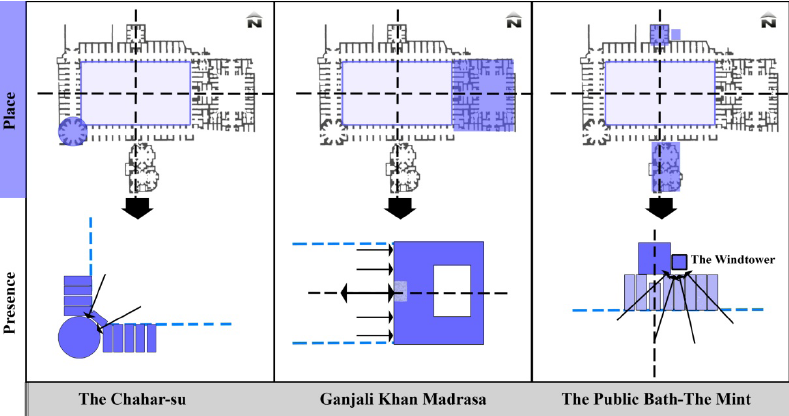
Figure 4. The modes of hierarchy provide the presentations of the unit combinations on two sides and one corner of the